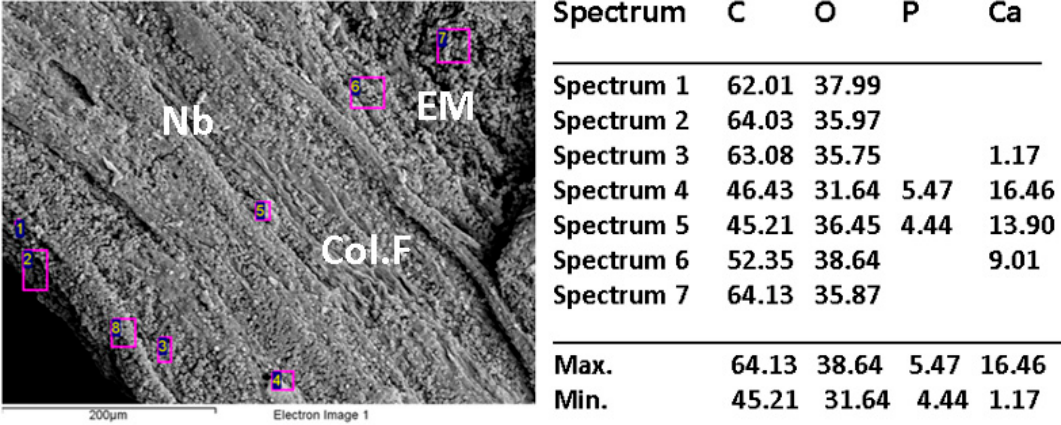
Figure 5. Scanning electron microscopy (SEM) /dispersive energy spectroscopy (EDS) analysis of control sample implanted in critical size defects in rat parietal bone Wistar . Nb: Newly born bone. EM: Extracellular matrix. Col-F: collagen fiber.